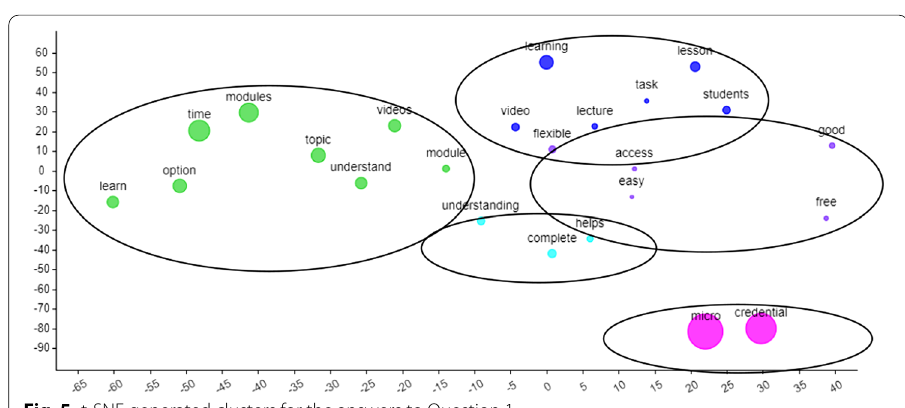
Fig. 5 t-SNE generated clusters for the answers to Question